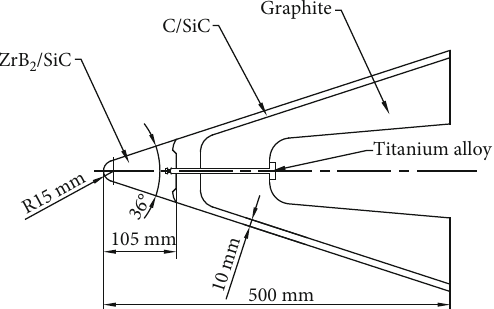
Figure 9: Geometry of the nose